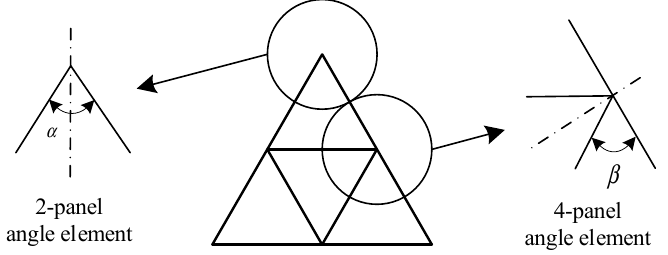
Figure 7. Cross-section of FTTC and two typical angle elements.